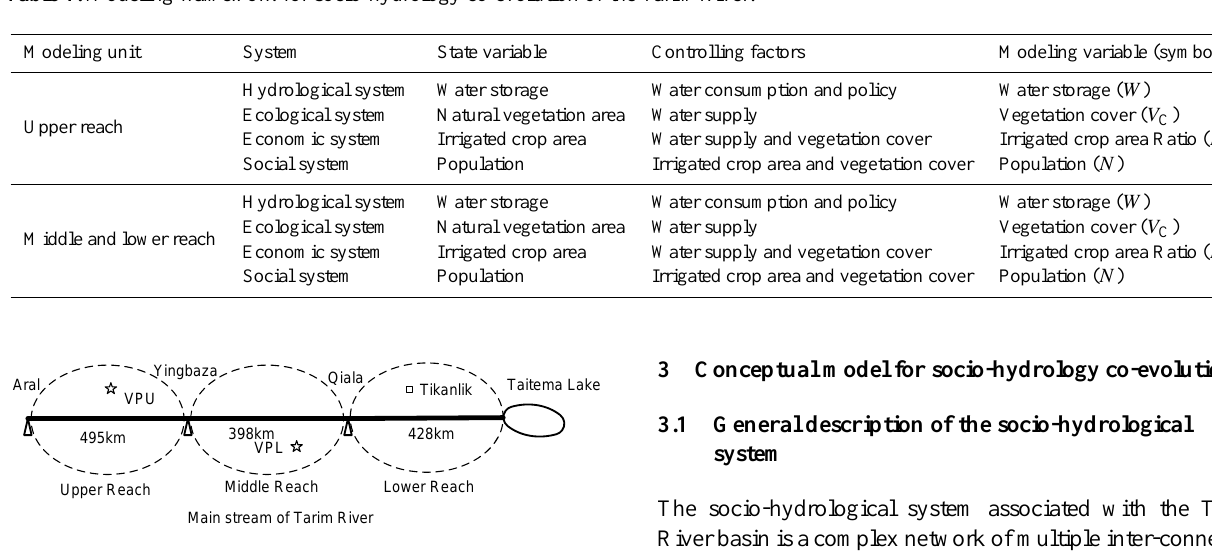
Table 1. Modeling framework for socio-hydrology co-evolution of the Tarim River.